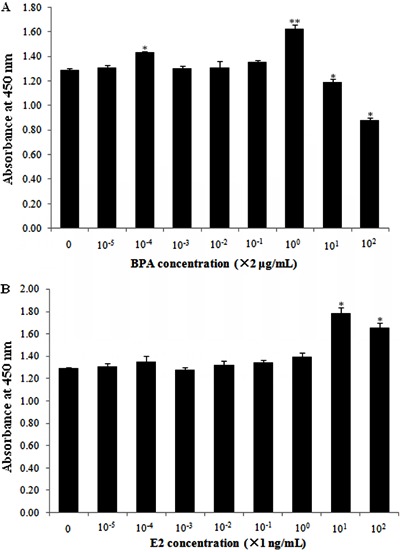
Screening for optimal concentrations of bisphenol A (BPA) and estradiol
(E2) to stimulate HepG2 cell proliferation. Data are reported as means±SD.
*P<0.05, **P<0.01 compared to no treatment (one-way ANOVA).